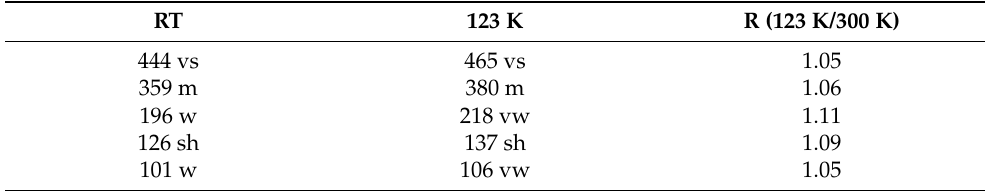
Table 2. Wavenumbers of selected Raman fundamentals [cm − 1 ] observed for KAgF 3 at 123 K and at room temperature, and their ratio, R